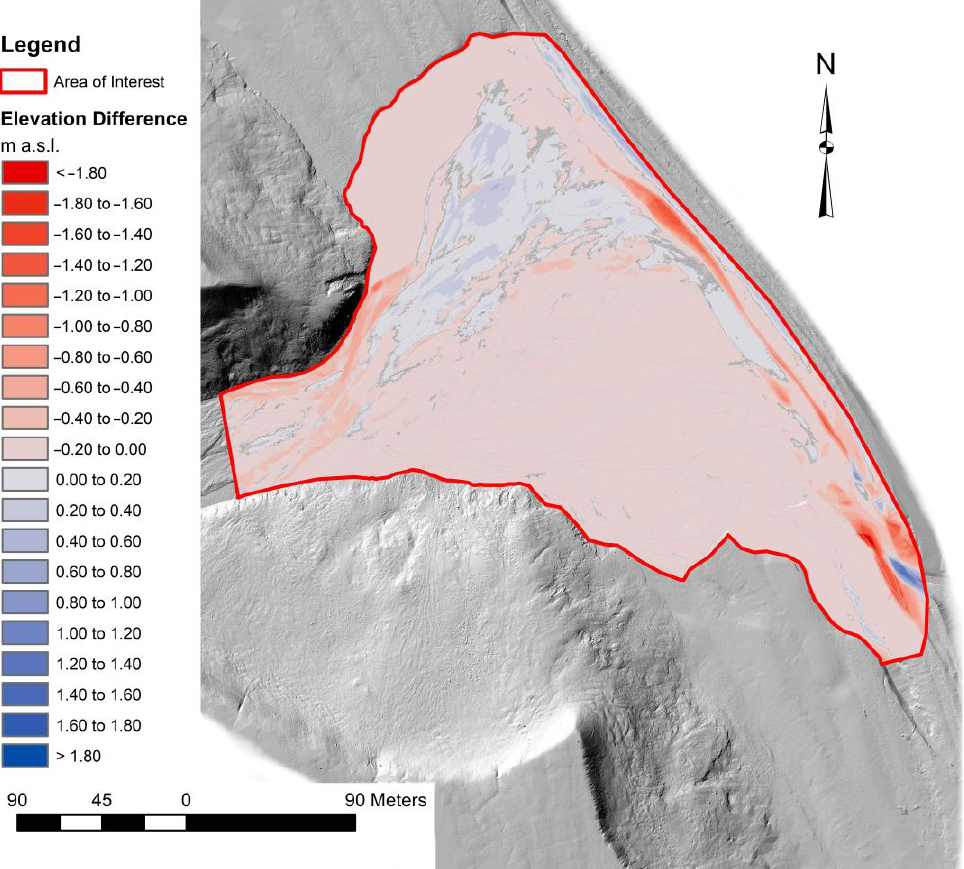
Figure 8. Geomorphic changes in the Scott River alluvial fan from July 2010 during the August 2013 flood event. AoI for the entire alluvial fan with MinLoD = 0.02. Hillshades map is shown behind DoD for context.